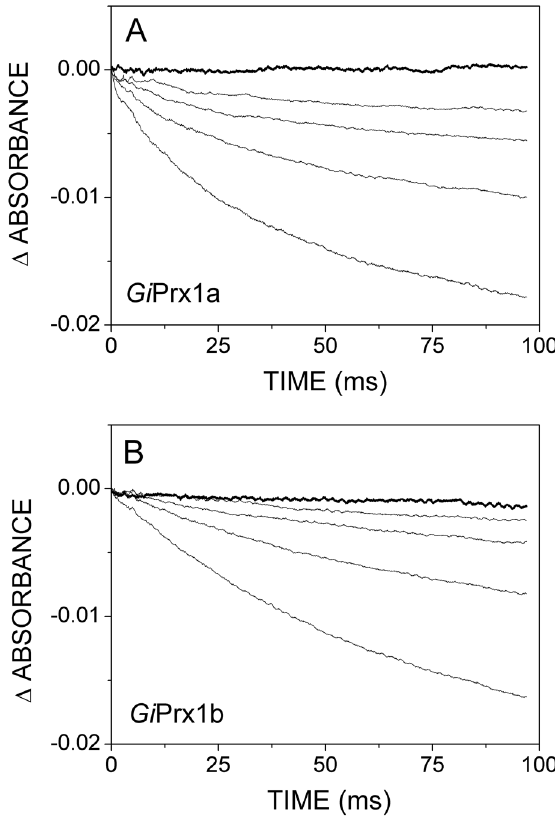
Figure 3. Reaction of reduced Gi Prxs with ONOO 2 . Absorption changes measured at 310 nm after anaerobically mixing in the stopped- flow apparatus a solution of ONOO 2 with degassed buffer alone (thick lines) or containing reduced G i Prx1a (A) or deltaG i Prx1b (B) at increasing concentrations (thin lines). T = 4 u C. Concentrations after mixing: [ONOO 2 ] = 20 m M; [G i Prx1a] = 0, 7.8, 15.5, 31 and 62 m M (from top to bottom); [deltaG i Prx1b] = 0, 4.7, 9.4, 13.8 and 37.5 m M (from top to